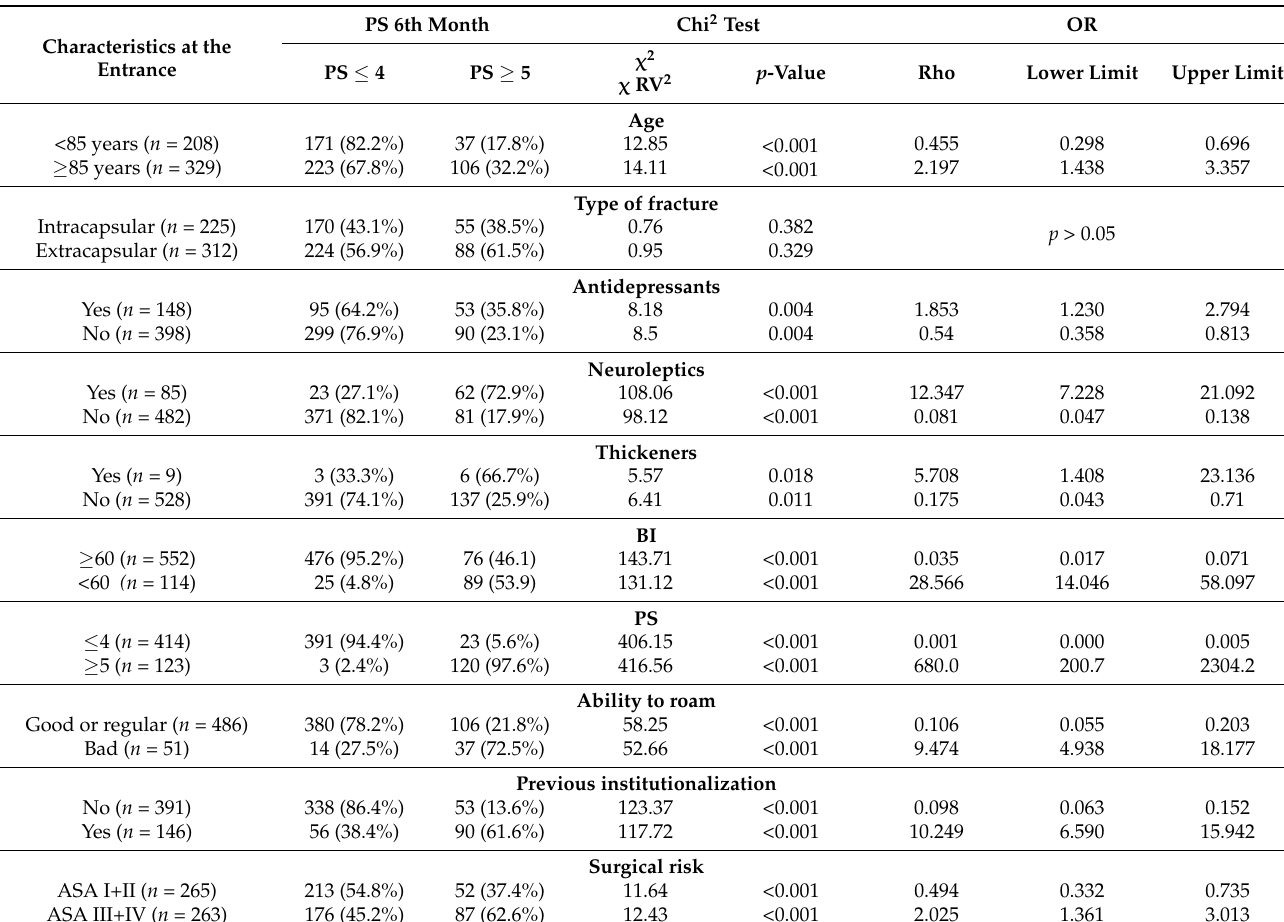
Table 1. Chi 2 test results between clinical features at admission and cognitive impairment at sixth month.